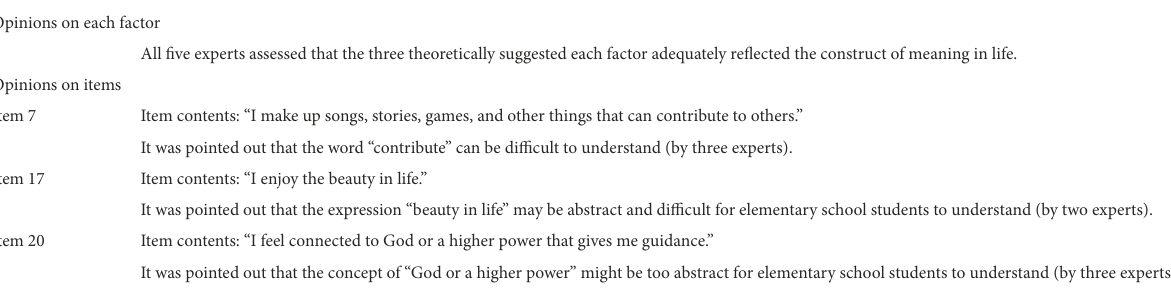
TABLE 2 Content analysis of the K-MIL-CQ by five experts. Opinions on each